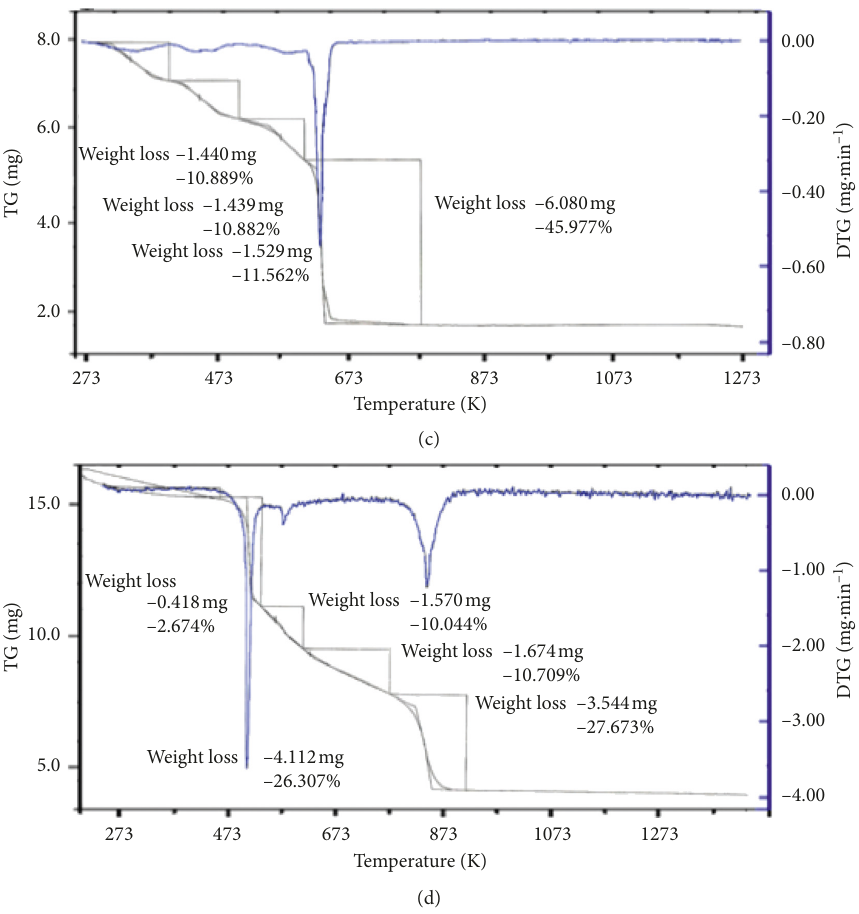
· 0.5H 2 O) 2 ] 2 O, (b) [Ni(glu)(arg)(H 2 O) 2 ]